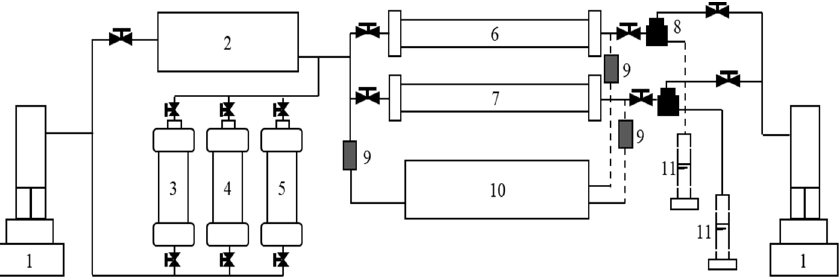
Figure 4. Schematic of the one-dimensional experiment. (1) ISCO pump; (2) steam generator; (3) formation water; (4) crude oil; (5) plugging agent; (6) high-permeability sand-pack; (7) low-permeability sand-pack; (8) back pressure regulator; (9) pressure sensor; (10) data acquisition system; (11) measuring cylinder.